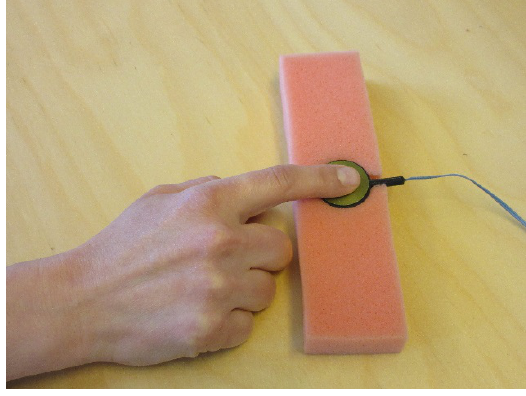
Figure 3. C2 Tactor haptic actuator.